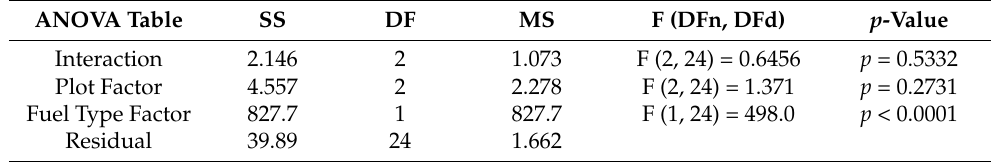
Table 3. Two-way ANOVA of fuel loading of live branches and surface dead fuel of P. yunnanensis .